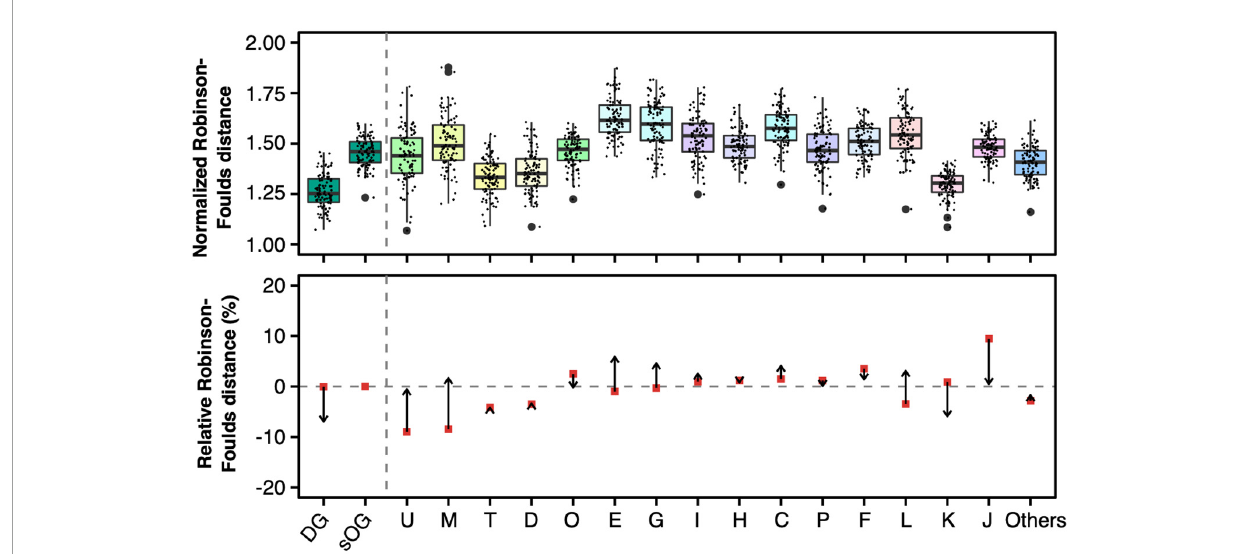
FIGURE7 Normalized Robison-Foulds distances (upper panel) and relative normalized Robison-Foulds distances ( lower panel) between single-gene trees and supermatrix (ST1). Like the lower panel of Figure 4 , the arrows start from the relative Robison-Foulds (RF) distances of general gene trees and point to the relative RF distances after normalization based on the number of parsimony-informative